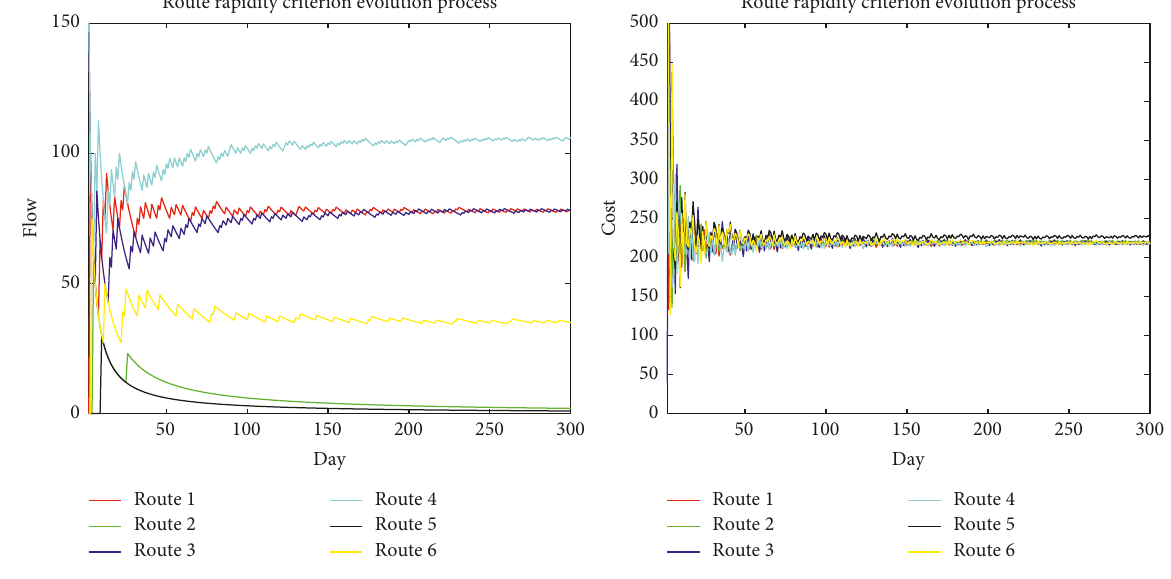
Figure 3: Evolutionary trajectories of route flows. Table 4: Route flow and cost in equilibrium.